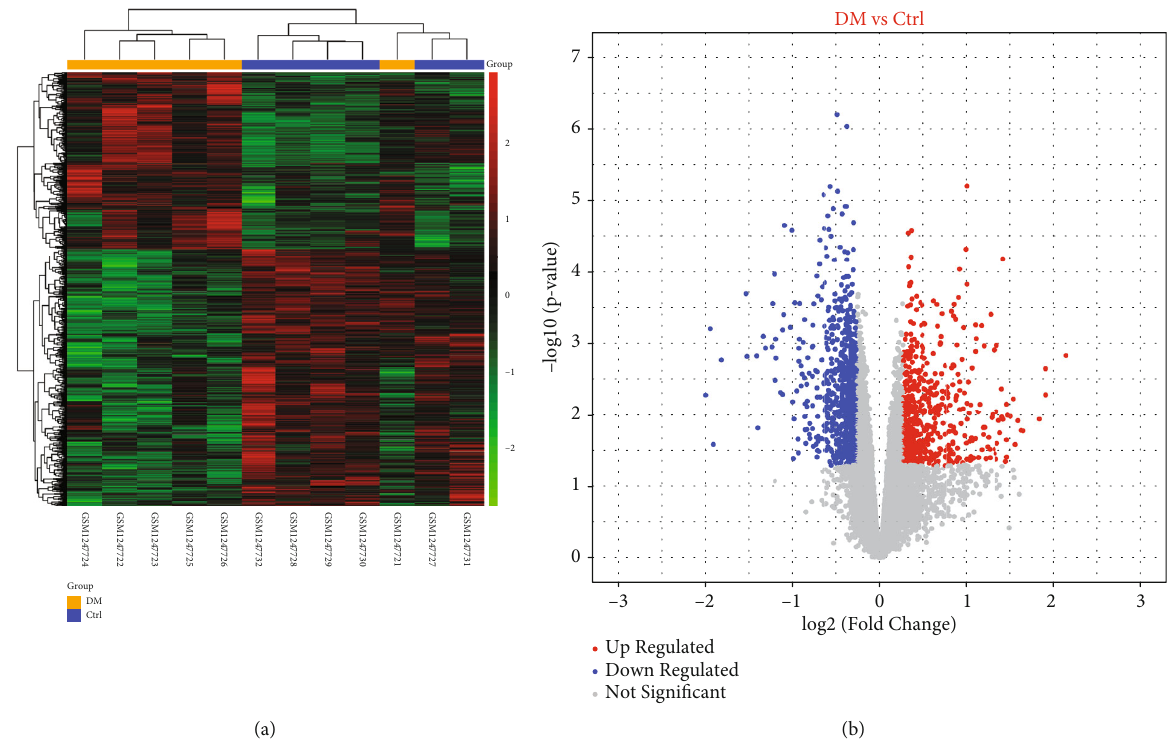
Figure 1: (a) Heatmap of di ff erentially expressed genes (DEGs) from the microarray analysis. The orange group is the gestational diabetes mellitus (GDM) group, while the blue group is the control group. The upregulated genes are shown in red, and the downregulated genes are shown in blue. (b) DEGs obtained from the microarray. The red points represent upregulated genes, and blue points represent downregulated genes. Gray points represent genes without a signi fi cant di ff erence in